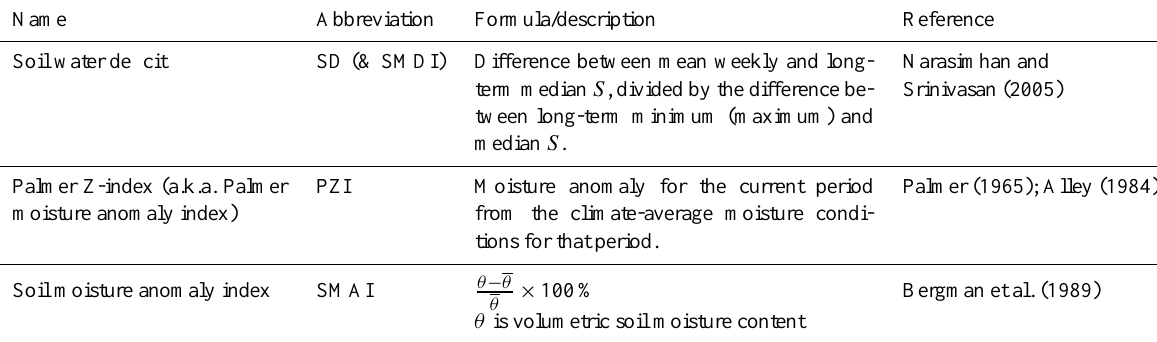
Table B4. Relative soil moisture availability